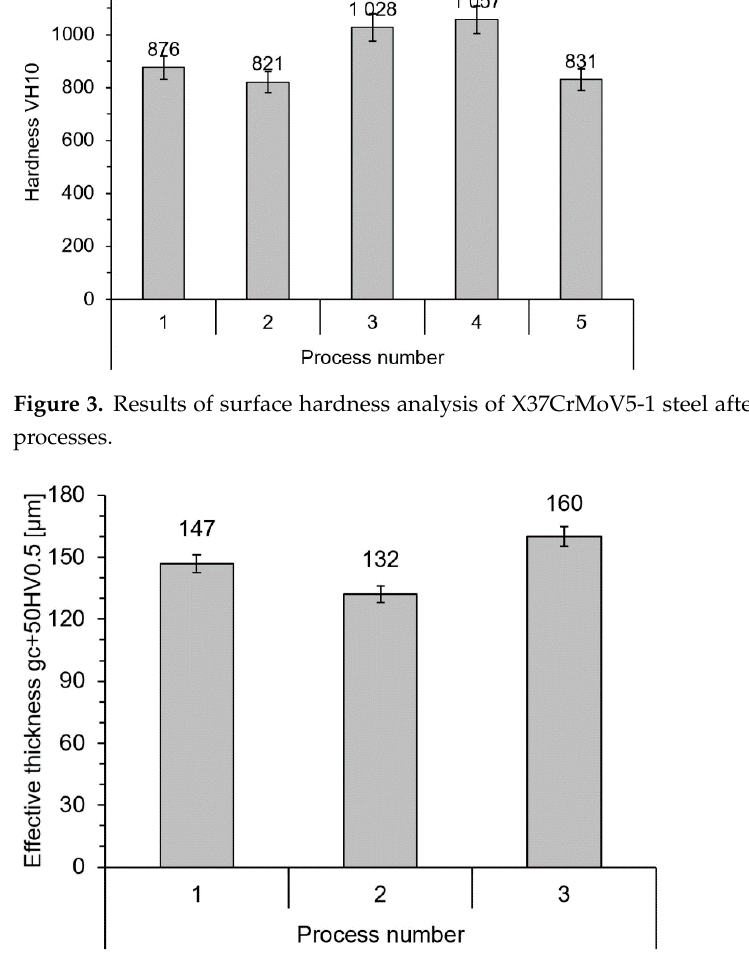
Commented [A5]: Please replace comma with dot in decimal numbers.